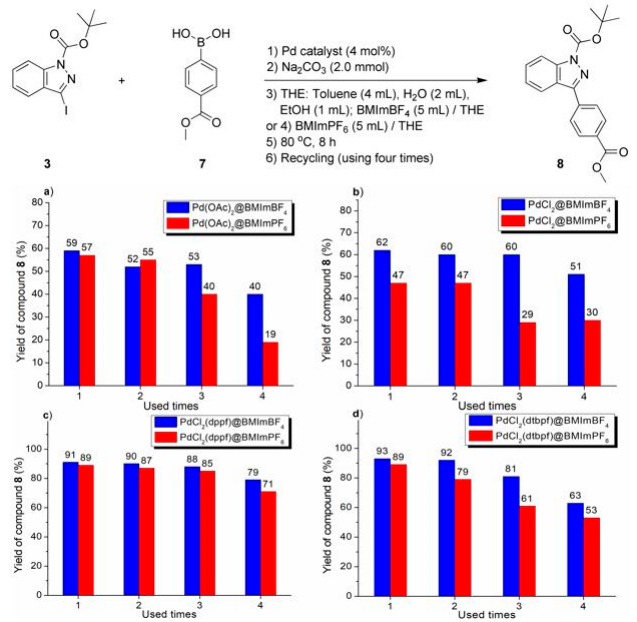
Figure 3. Recycling experiments on Suzuki–Miyaura cross-coupling of compounds 3 with 7 cata- lyzed by Pd catalyst immobilized over imidazolium ionic liquid: ( a ) Pd(OAc) 2 over ILs; ( b ) PdCl 2 over ILs; ( c ) PdCl 2 (dppf) over ILs; ( d ) PdCl 2 (dtbpf) over ILs. ( c ) PdCl 2 (dppf) over ILs; ( d ) PdCl 2 (dtbpf) over